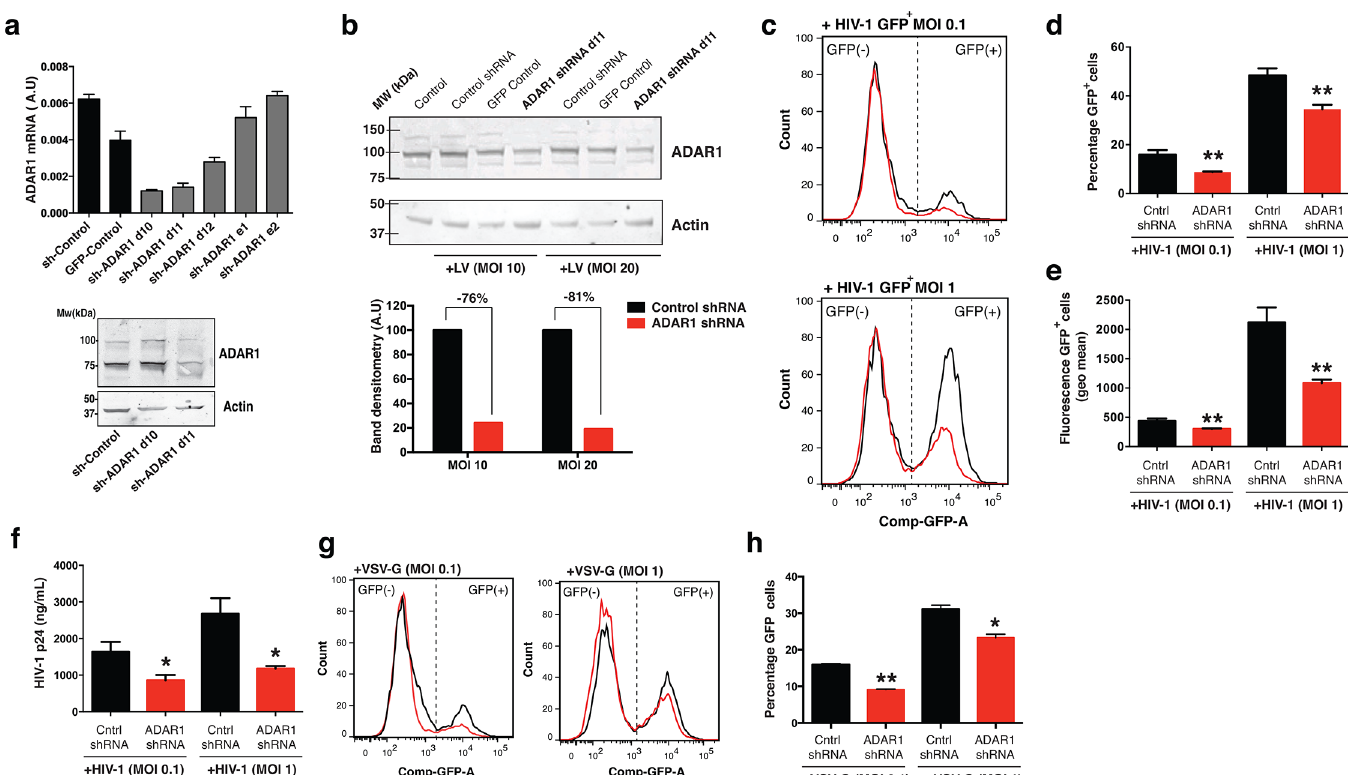
Fig 2. Silencing ADAR1 restricts HIV-1 replication in Jurkat T cells. (a) Jurkat T cells were stable transduced with shRNA control, GFP control or ADAR1 shRNAs. Bar graph shows normalized ADAR1 mRNA levels. Panel shows western blot of the two best shRNA targeting ADAR1. (b) Cells were transduced at MOI 10 or 20. Panels show representative western blot of ADAR1 protein reduction in ADAR1 shRNA transduced cells. Bar graphs show densitometry analysis of bands compared to Control shRNA. Actin was used as loading control. (c) Control shRNA (n = 4) and ADAR1 shRNA (n = 4) transduced Jurkat T cells were challenged with equivalent infectious units of HIV-1 GFP virus (MOI 0.1 or 1) and analyzed by FACS on day 5 after infection. Panels show representative dot plots of FACS analysis from transduced cells. The viable cells (gate, left graphs) were analyzed for GFP fluorescence. Histograms show GFP signal of Control shRNA (black line) and ADAR1 shRNA cells (red line) after HIV1-GFP infection at different MOIs. (d) Bar graph representing the mean ± s.d. of GFP+ infected cells (n = 4), ** P < 0.01. (e) Bar graph representing the mean ± s.d. of GFP fluorescence of infected cells (n = 4), ** P < 0.01. (f) Bar graphs represent mean ± s.d. (n = 3) of HIV-1 p24 protein amounts released into the cell culture supernatant on day 5 after infection, * P < 0.05. (g) Histograms show GFP signal of control shRNA (black line) and ADAR1 shRNA cells (red line) after VSV-G-GFP infection at different MOIs. (h) Bar graph representing the mean ± s.d. of GFP+ infected cells (n = 3) ** P < 0.01, * P < 0.05.